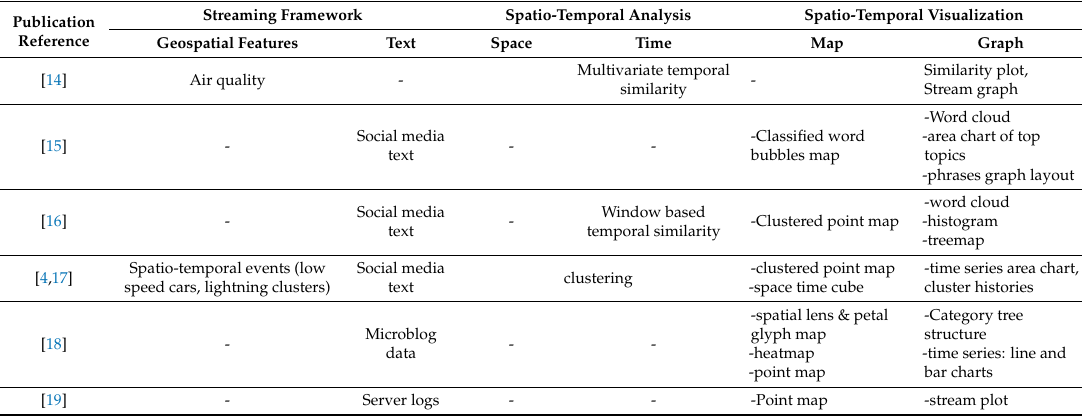
Table 1. An overview of spatio-temporal and streaming data